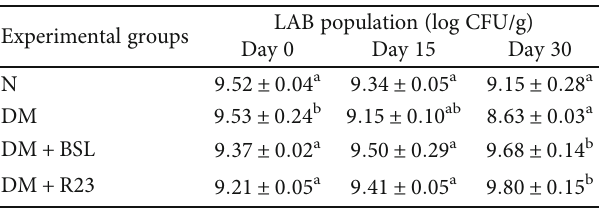
Figure 5: E ff ect of L. rhamnosus BSL and L. rhamnosus R23 on Pepck (a) and G6pc (b) mRNA expression in the liver of experimental groups. The values are expressed as the means ± SD ( n = 6 ). The values with di ff erent superscript letters are signi fi cantly di ff erent ( P < 0 : 05 ). Table 3: Fecal LAB populations on days 0, 15, and 30 after L. rhamnosus BSL and L. rhamnosus R23